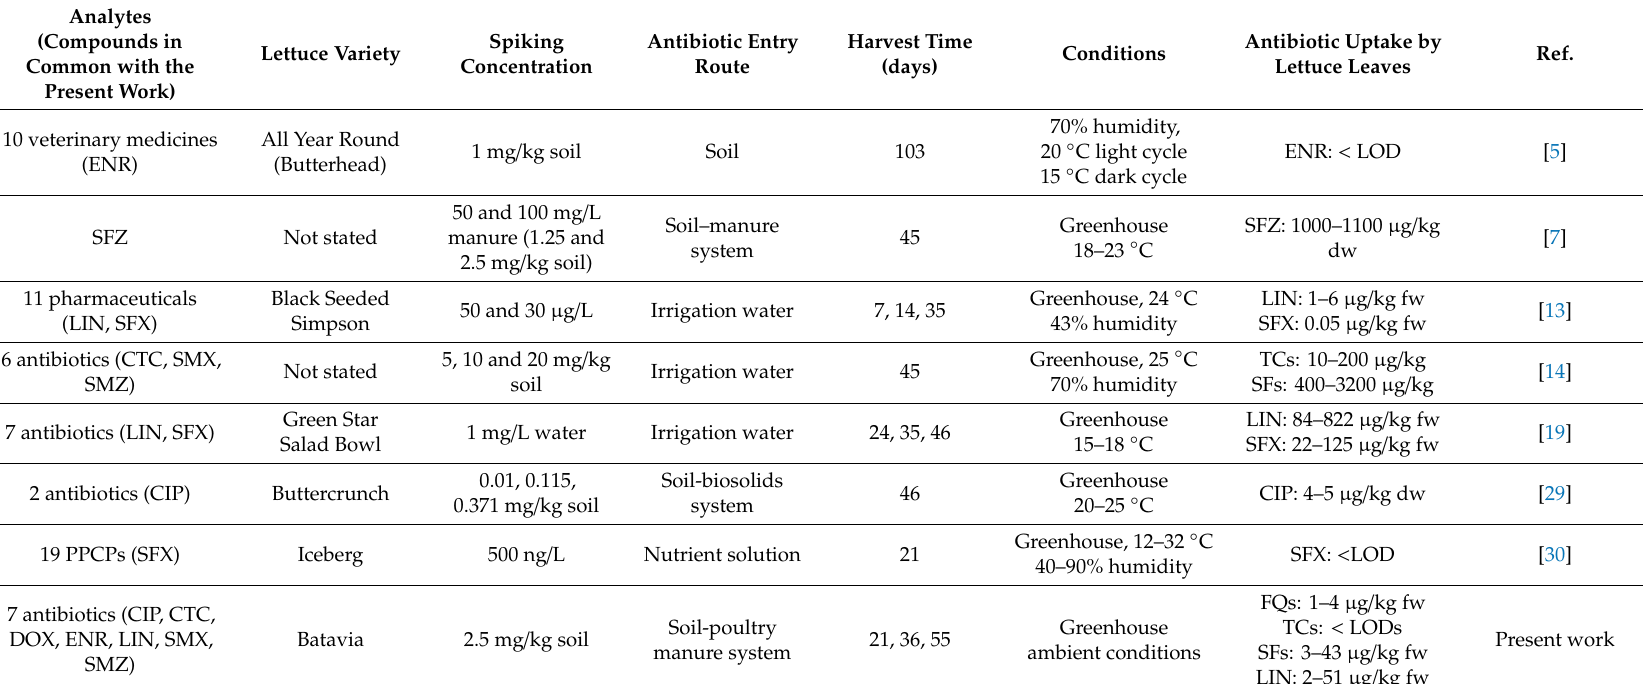
Table 3. Summary of studies where the uptake of antibiotics by lettuce was